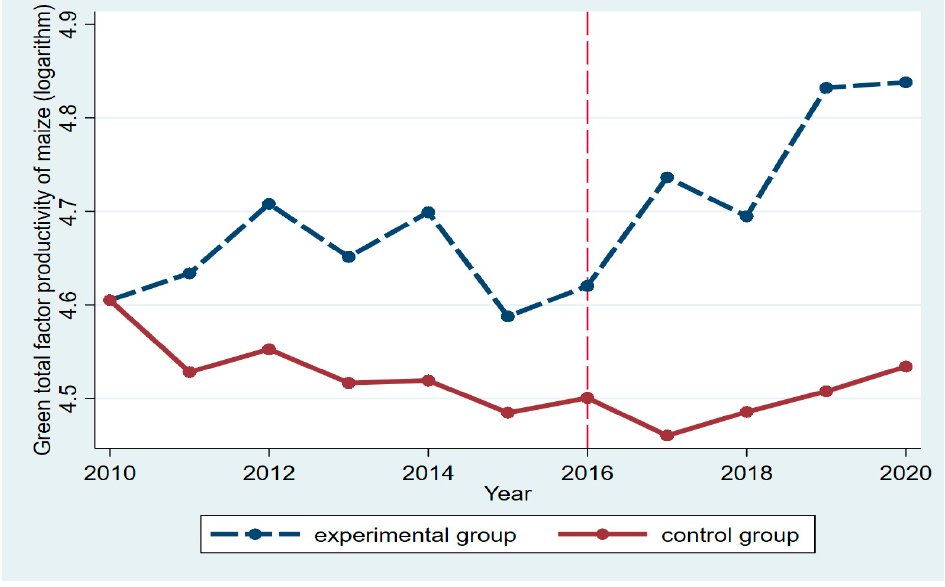
Figure 2. Dynamic change of MGTFP in the control group and experimental group. Table 4. DID regression